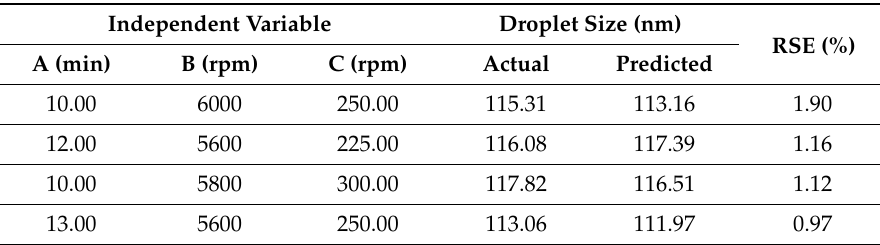
Table 4. Validation set for verification of the final model obtained.